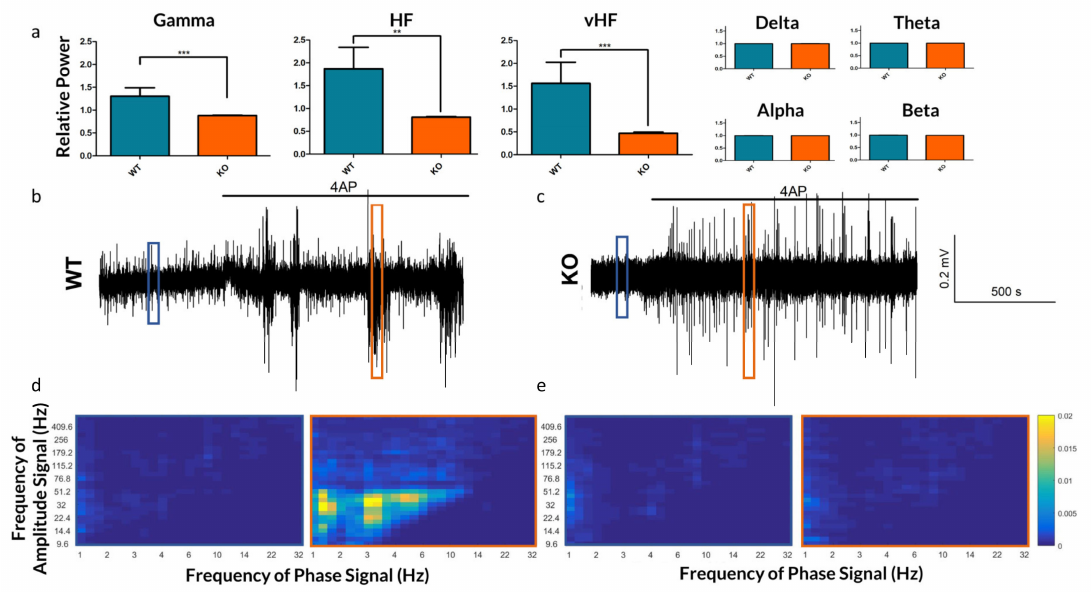
Figure 4. Frequency-based analysis of the extracellular recordings of Panx1 KO mice and their WT counterparts. ( a ) The relative increase by frequency band in neocortical field potentials after bath application of 4-AP. As 4-AP induces broadband increased spectral power, the relative increase in power of each band is normalized to the overall increase in spectral power. While changes in Delta through Beta bands were not significant, the increase in spectral power in Gamma ( p = 0.0009), HF ( p = 0.0011) and vHF ( p = 0.0008) bands were significantly lower in Panx1 deficient animals following 4-AP. ( b , c ) Traces of WT and KO extracellular recordings under 4-AP. ( d , e ) Phase-amplitude coupling comodulograms of 10-s windows during baseline (blue) and 4-AP (orange) conditions, as highlighted in subfigures b and c respectively, highlighting periods of enhanced PAC in the WT 4-AP response which are absent in the KO. ** p < 0.01, *** p <